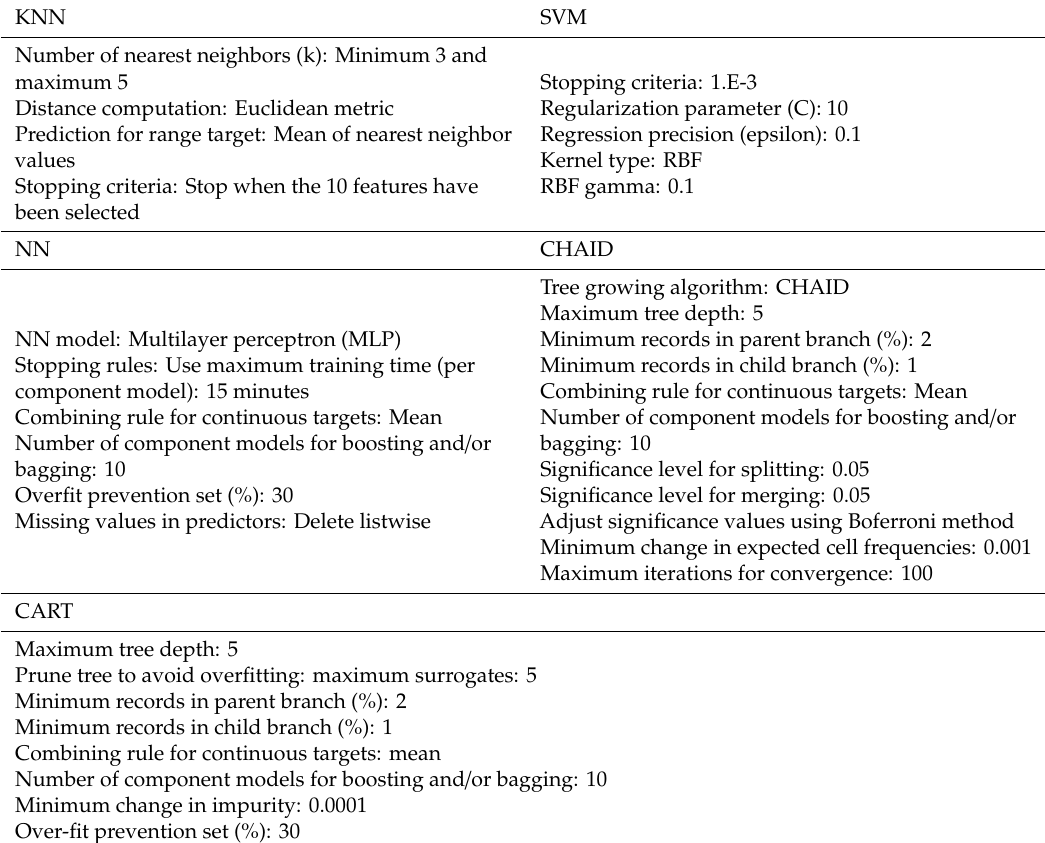
Table 2. Parameters of the algorithms used in this